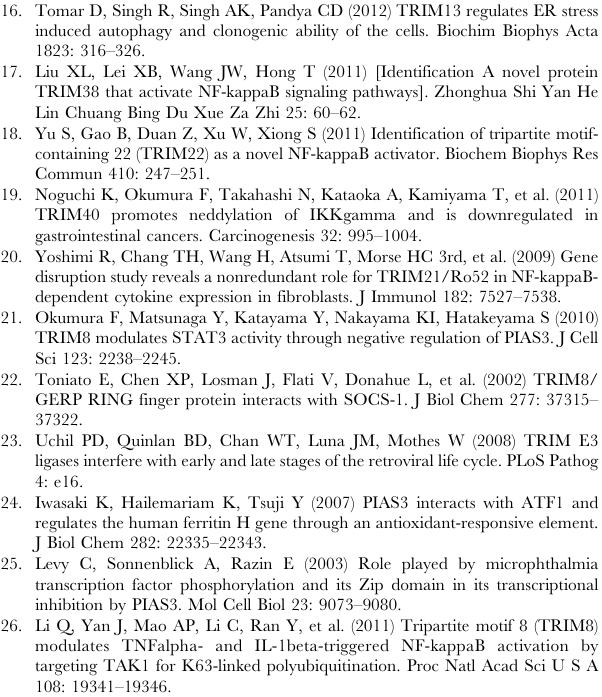
Figure S1 TRIM8 positively regulates TNF induced NF- k B. HEK293 cells were transfected with TRIM8 and vector; treated with TNF a (10 ng/ml) for different time interval and NF- k B activation measured by Dual Glo luciferase assay. Asterisk (*) indicates p value , 0.05 for SEM of minimum three independent experiments. Figure S2 TRIM8 expression has no effect on p65 protein turnover. HEK293 cells were co-transfected with